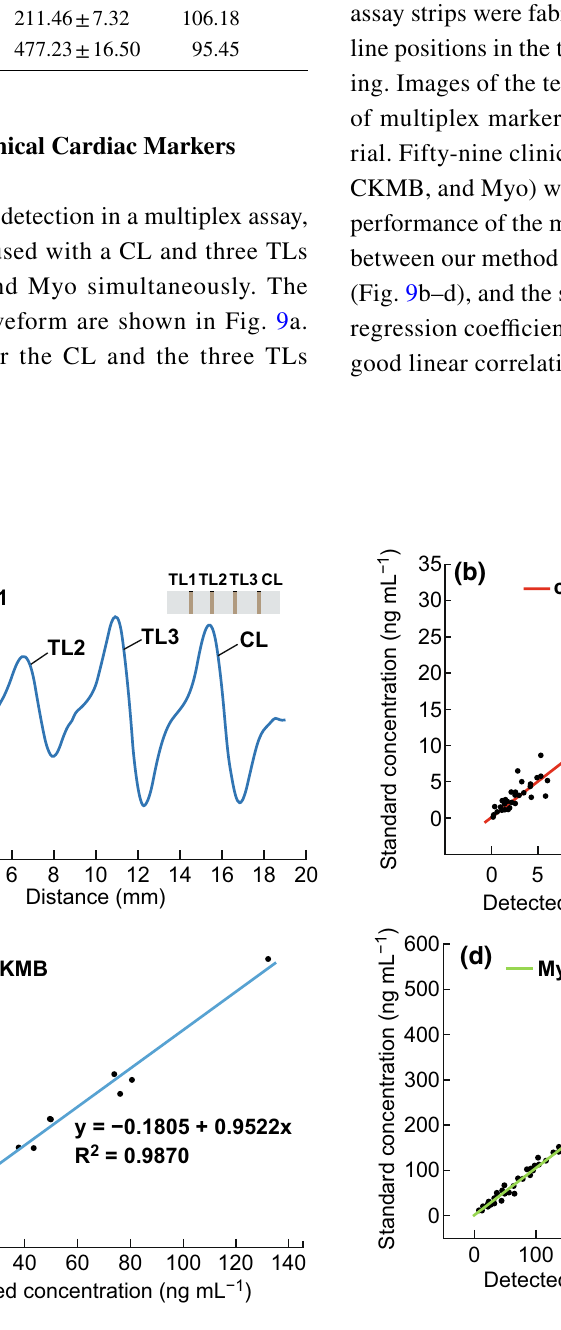
Fig. 9 a Multiplex line strip and its waveform for detecting cTnI (TL1), CKMB (TL2), and Myo (TL3) simultaneously. Correlation between the results obtained by clinical ECLIA methods and this platform for b cTnI, c CKMB, and d Myo detection in serum